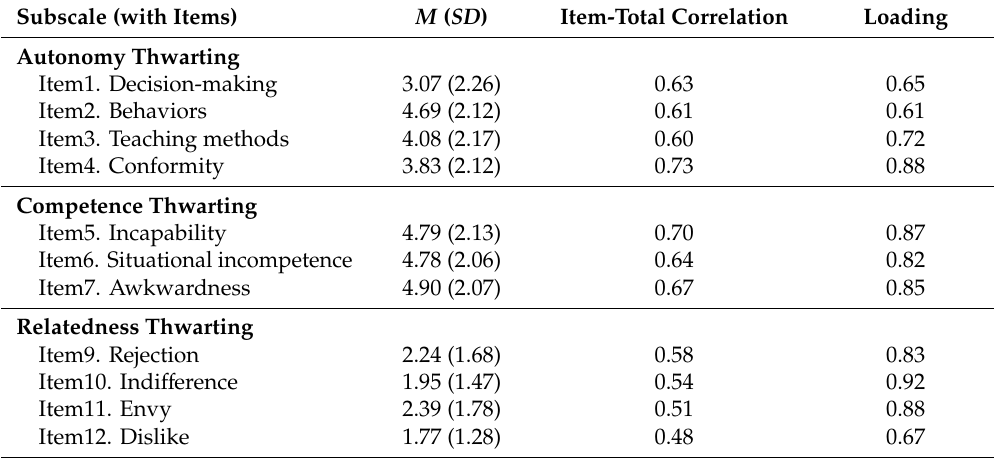
Table 3. Item properties of the CPNTT, including mean, standard deviation, item-total correlation, and